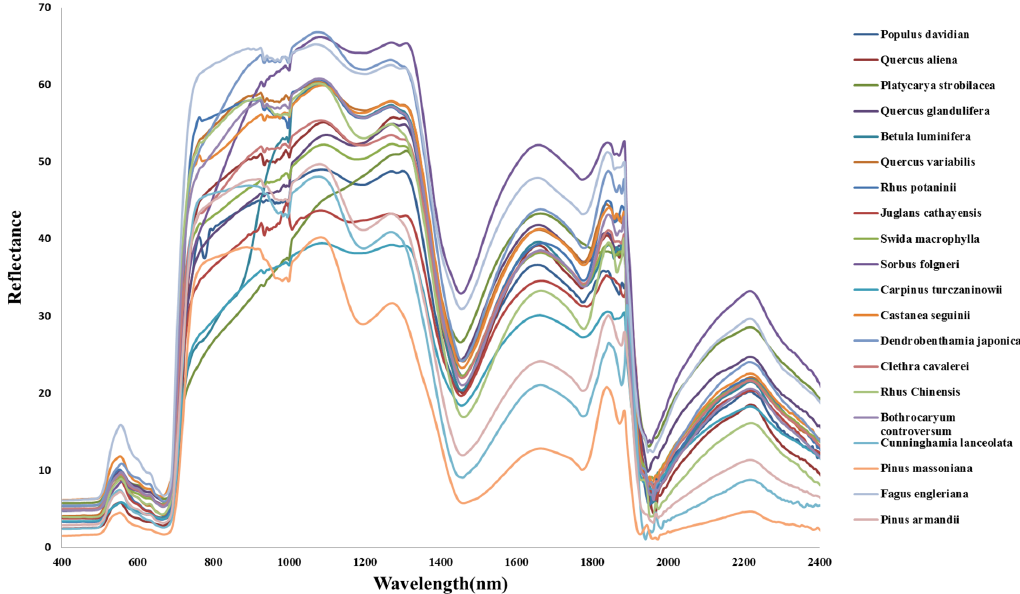
Figure 3. Savitzky–Golay filtered field spectral signatures of 20 dominant tree species.